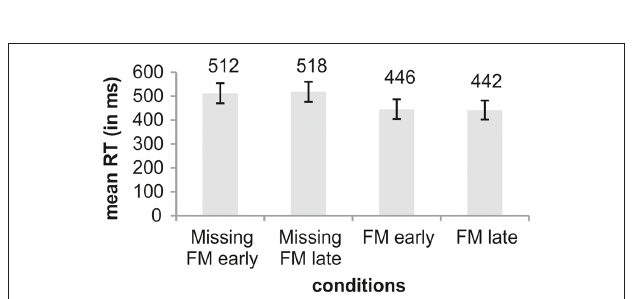
Figure 3 | illustration of mean d ′ values for the conditions Missing FM early , Missing FM late, FM early, and FM late . An error bar displays the SD. Differences between conditions were tested using pairwise comparison.